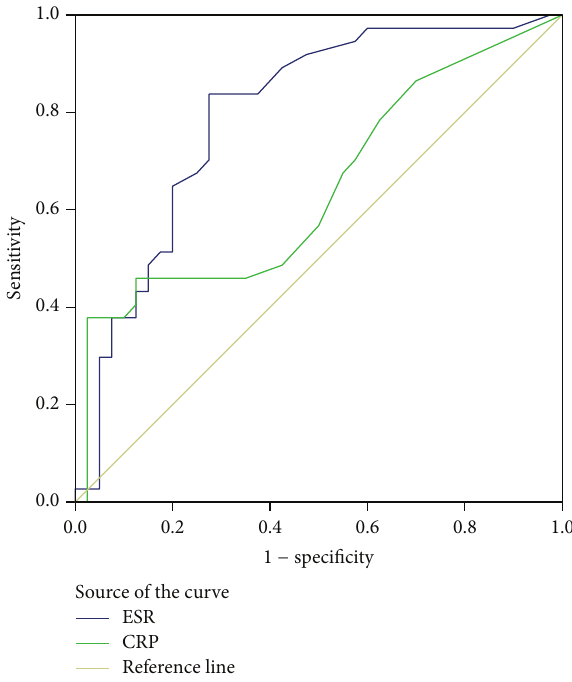
Figure 1: Receiver operating characteristic (ROC) curve to detect the best cutoff value for ESR and CRP in the prediction of systemic hypertension in sarcoidosis patients. ESR had an AUC value of 0.795 (95% CI 0.692–0.897, 𝑃 = 0.0001 ). A cutoff value for ESR of 30mm/hr yielded a 62% sensitivity and 80% specificity for predicting systemic hypertension in sarcoidosis patients. With regard to CRP, the AUC value is 0.644 (95% CI 0.518–0.769, 𝑃 = 0.03 ). A cutoff value for CRP of 3mg/L yielded a 37% sensitivity and 95% specificity for predicting systemic hypertension in sarcoidosis patients.